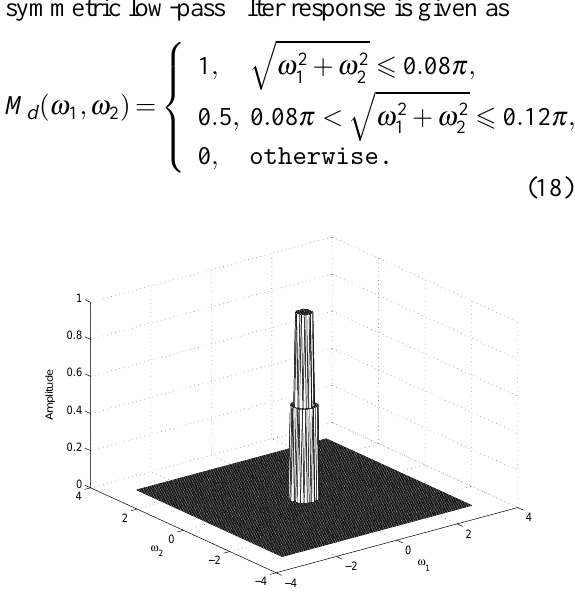
Fig. 2. Desired amplitude response of the 2-D filter.